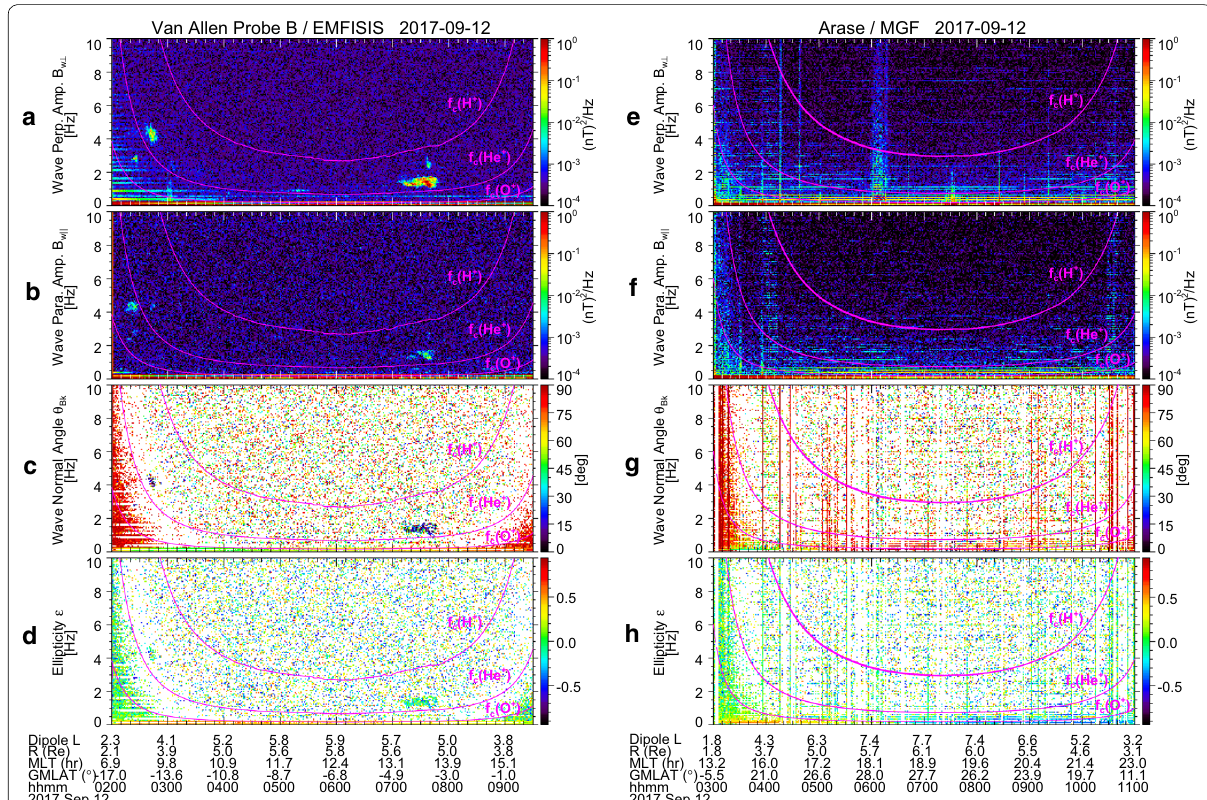
Fig. 5 Van Allen Probe B/EMFISIS observations of ( a , b ) the dynamic power spectra of wave amplitudes in the directions perpendicular and parallel to the local magnetic field, c wave normal angle with respect to the magnetic field, and d wave ellipticity, from 02:00 UT to 09:30 UT on 12 September 2017. Positive (negative) values of the wave ellipticity indicate right-handed (left-handed) polarization. Values of the wave normal angle and the ellipticity are shown only when degree of polarization is greater than or equal to 0.8. Magenta lines indicate local cyclotron frequencies of H + , He + , and O + ions. e – h Same as in a – d but for the Arase/MGF observations during 03:00–11:00 UT on 12 September